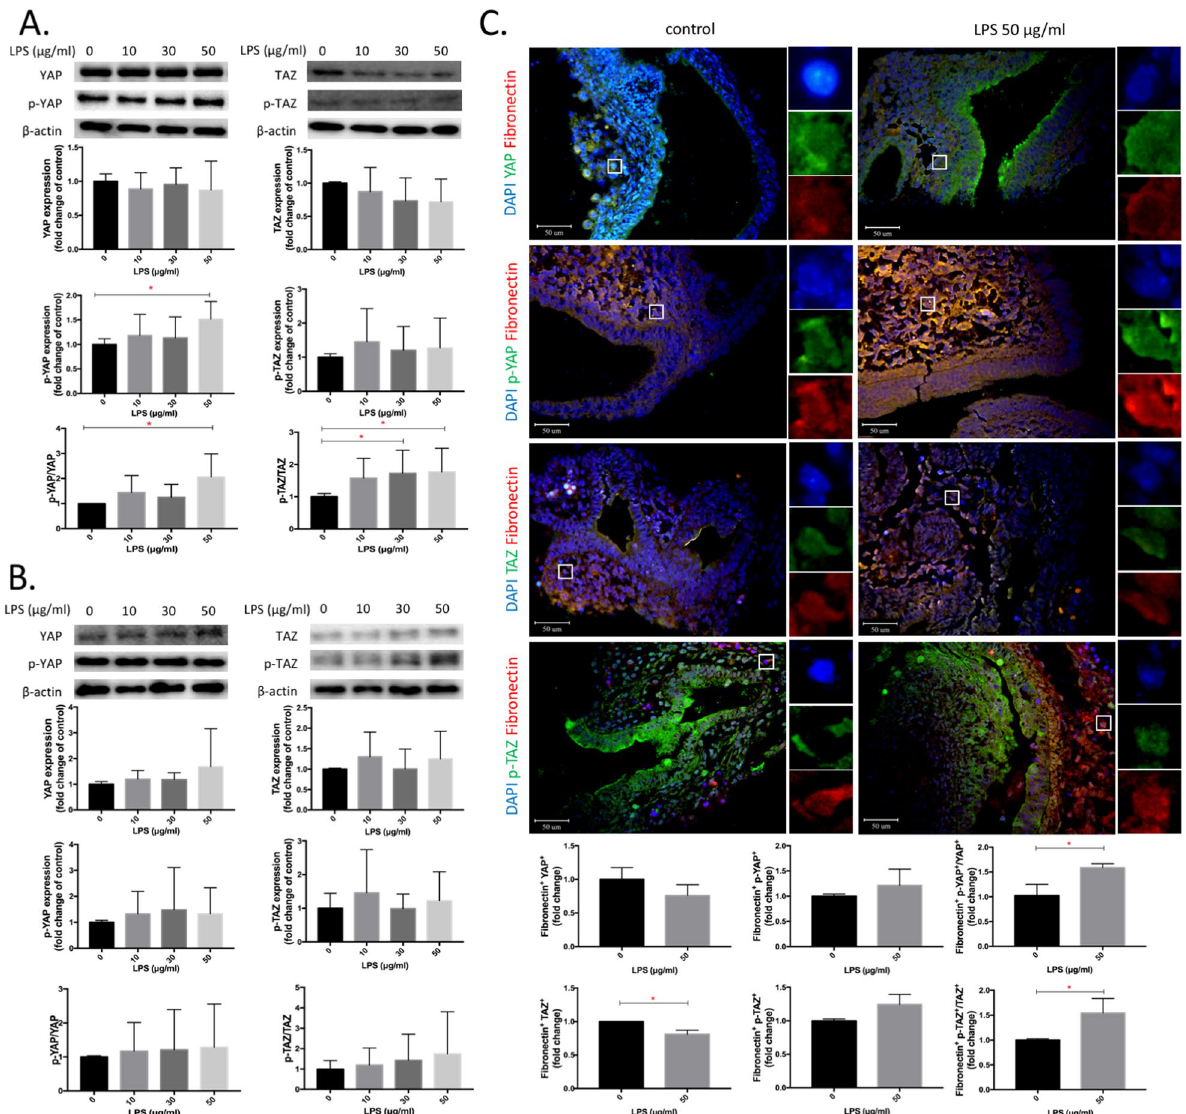
Fig. 3 Expression of Yes‑associated protein (YAP), phosphorylated (p)‑YAP, transcription coactivator with PD2‑binding motif (TAZ) and p‑TAZ in IMR‑90 cells, ex vivo fetal lungs, and fibroblasts of ex vivo fetal lungs by lipopolysaccharide (LPS). A Expressions of YAP, p‑YAP, p‑YAP/YAP, TAZ, p‑TAZ, and p‑TAZ/TAZ in IMR‑90 cells by LPS at 0, 10, 30, and 50 μg/ml for 24 h ( n 6). B Expressions of YAP, p‑YAP, p‑YAP/YAP, TAZ, p‑TAZ, and p‑TAZ/TAZ in = whole fetal lungs by LPS at 0, 10, 30, and 50 μg/ml for 3 days ( n 6). C Expressions of fibronectin + YAP, p‑YAP, p‑YAP/YAP, TAZ, p‑TAZ, and p‑TAZ/TAZ = of fetal lungs by LPS at 0 and 50 μg/ml for 3 days. DAPI (in blue) marked nuclear staining. Fibronectin (in red). YAP, p‑YAP, TAZ, and p‑TAZ (in green) ( n 3). *p < =